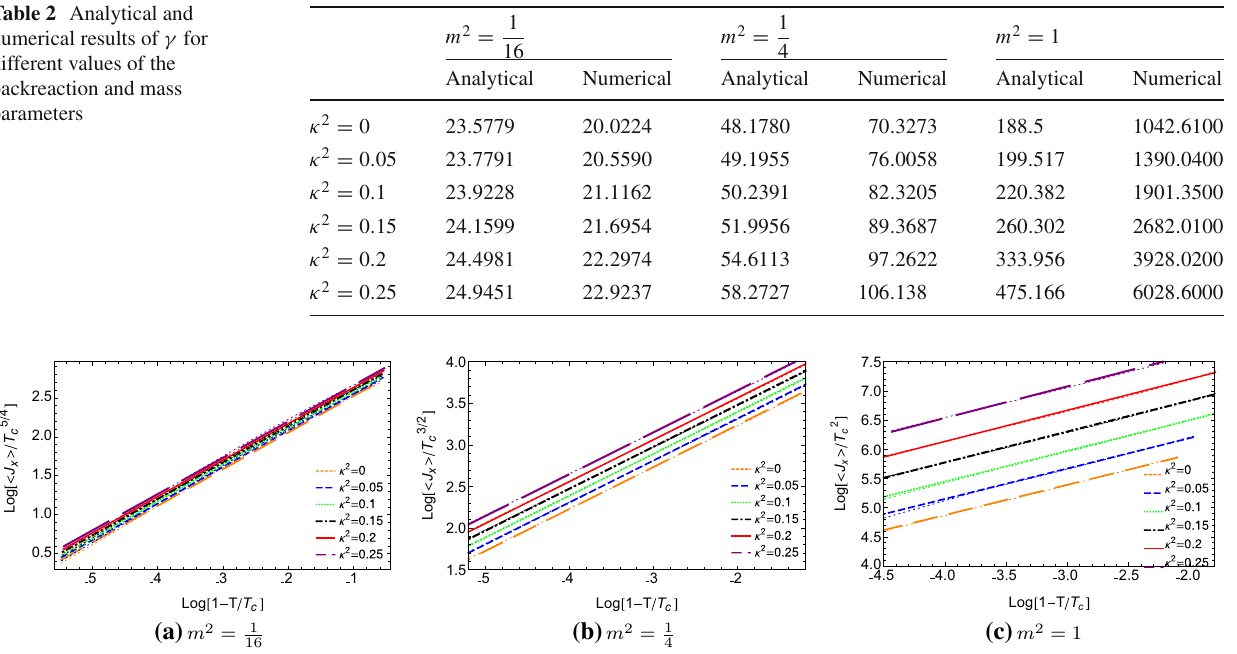
Fig. 2 The behavior of log (cid:10) J x (cid:11) / T (cid:14) + 1 c as a function of log ( 1 − T / T c ) with slope of 1 / 2 for different values of mass and backreaction